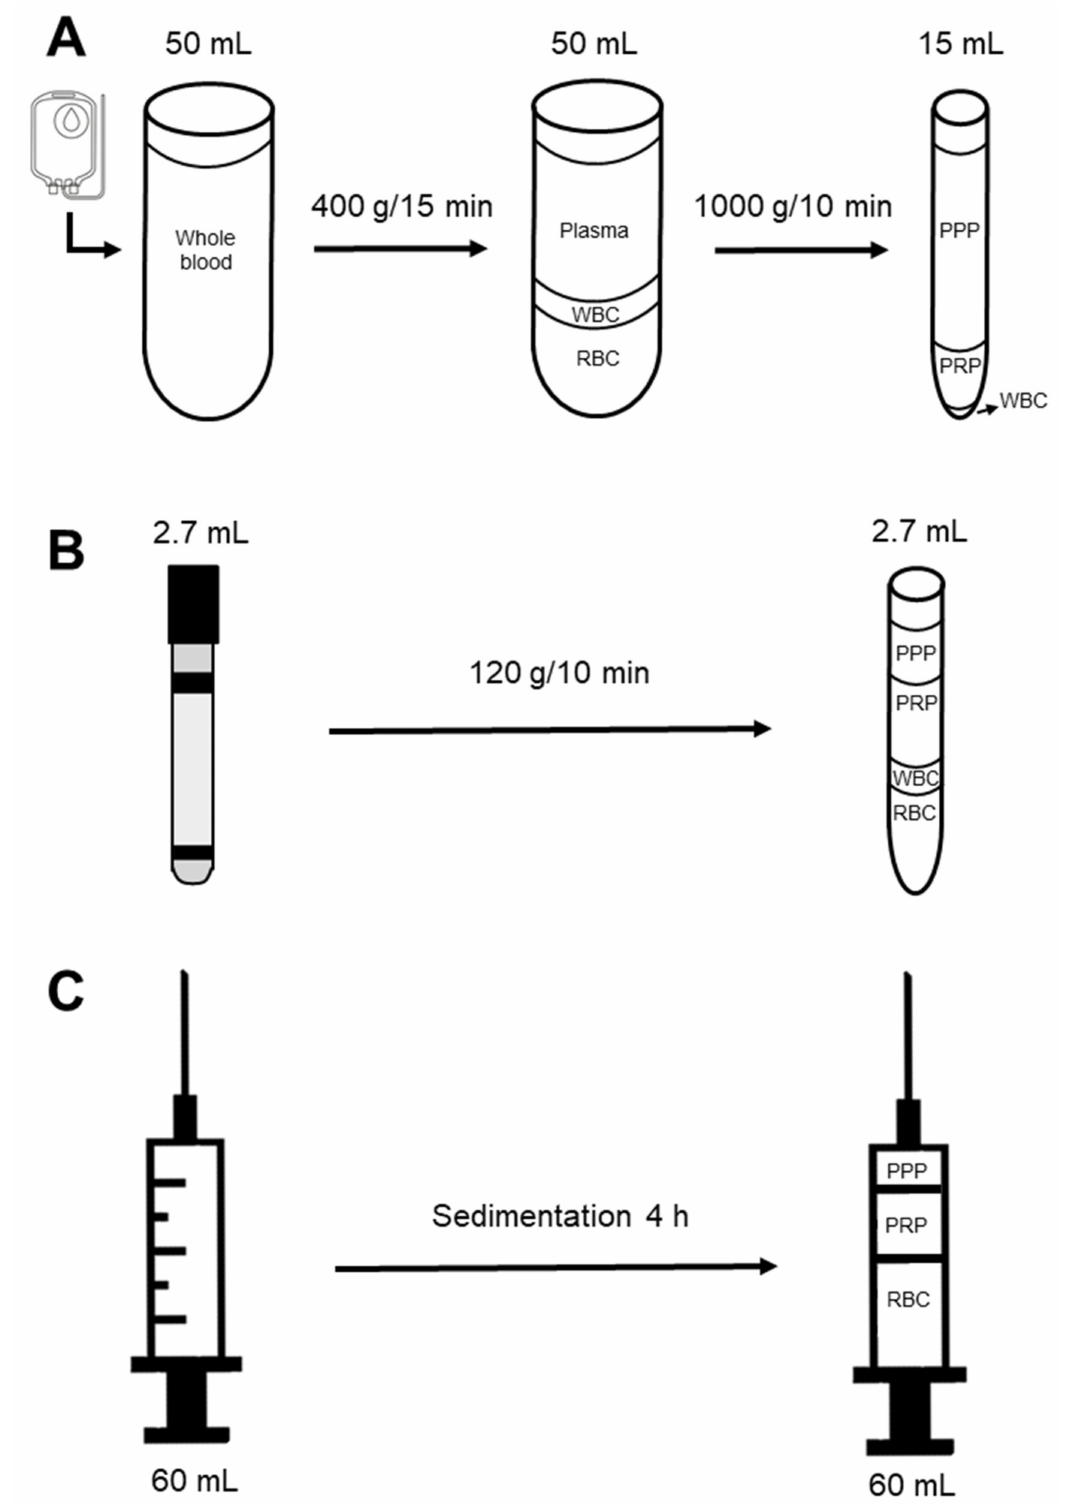
Figure 1. Diagram of three methods to prepare platelet-rich plasma (PRP) for intrauterine infusions in mares. ( A ) Method 1, blood was collected in a 150 mL blood transfusion bag and processed by 2-step centrifugation; ( B ) Method 2, blood was collected in 2.7 mL vacutainer tubes and processed by one-step centrifugation; ( C ) Method 3, blood was collected in a 60 mL syringe and PRP produced by sedimentation. Abbreviations: PPP, platelet-poor plasma; WBC, white blood cells; RBC, red blood